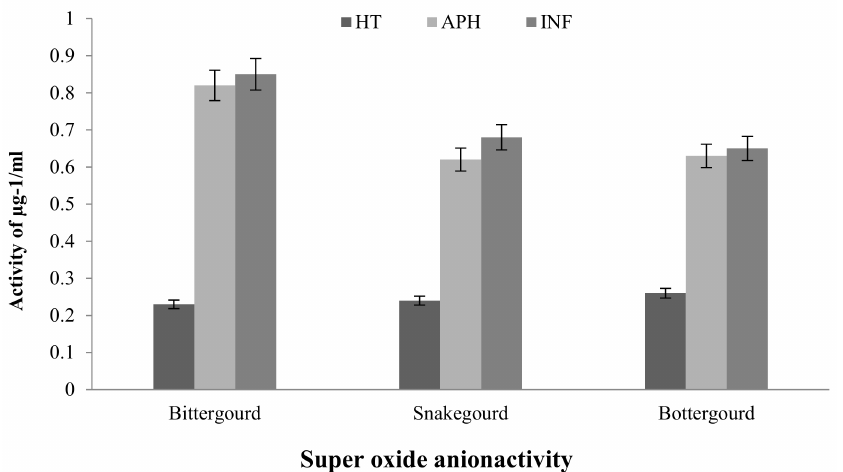
Figure 2. The superoxide anion antioxidant activity of melon fly infection n healthy (HT), apparently healthy (APH), and infected (INF) tissue extracts of cucurbit fruit. The vertical bars indicate the standard error. Significance at p ≤